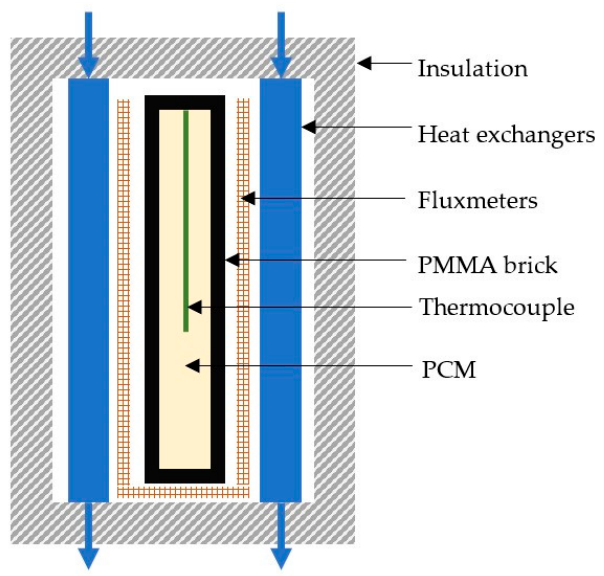
Figure 2. Principle of the STEP method.